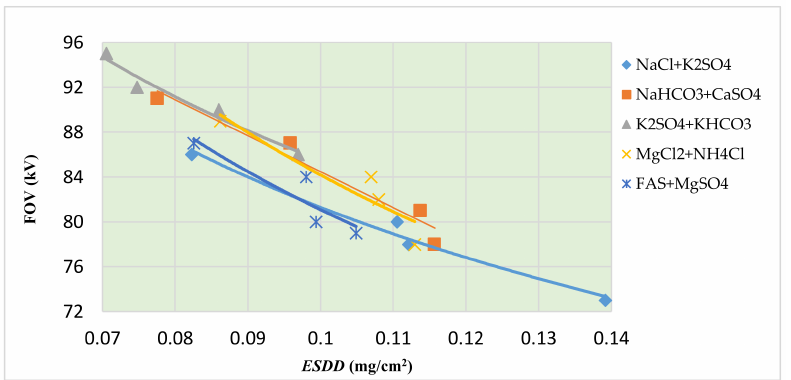
Figure 3. ESDD vs. FOV characteristics of the insulator contaminated with soluble agricultural pollutants.